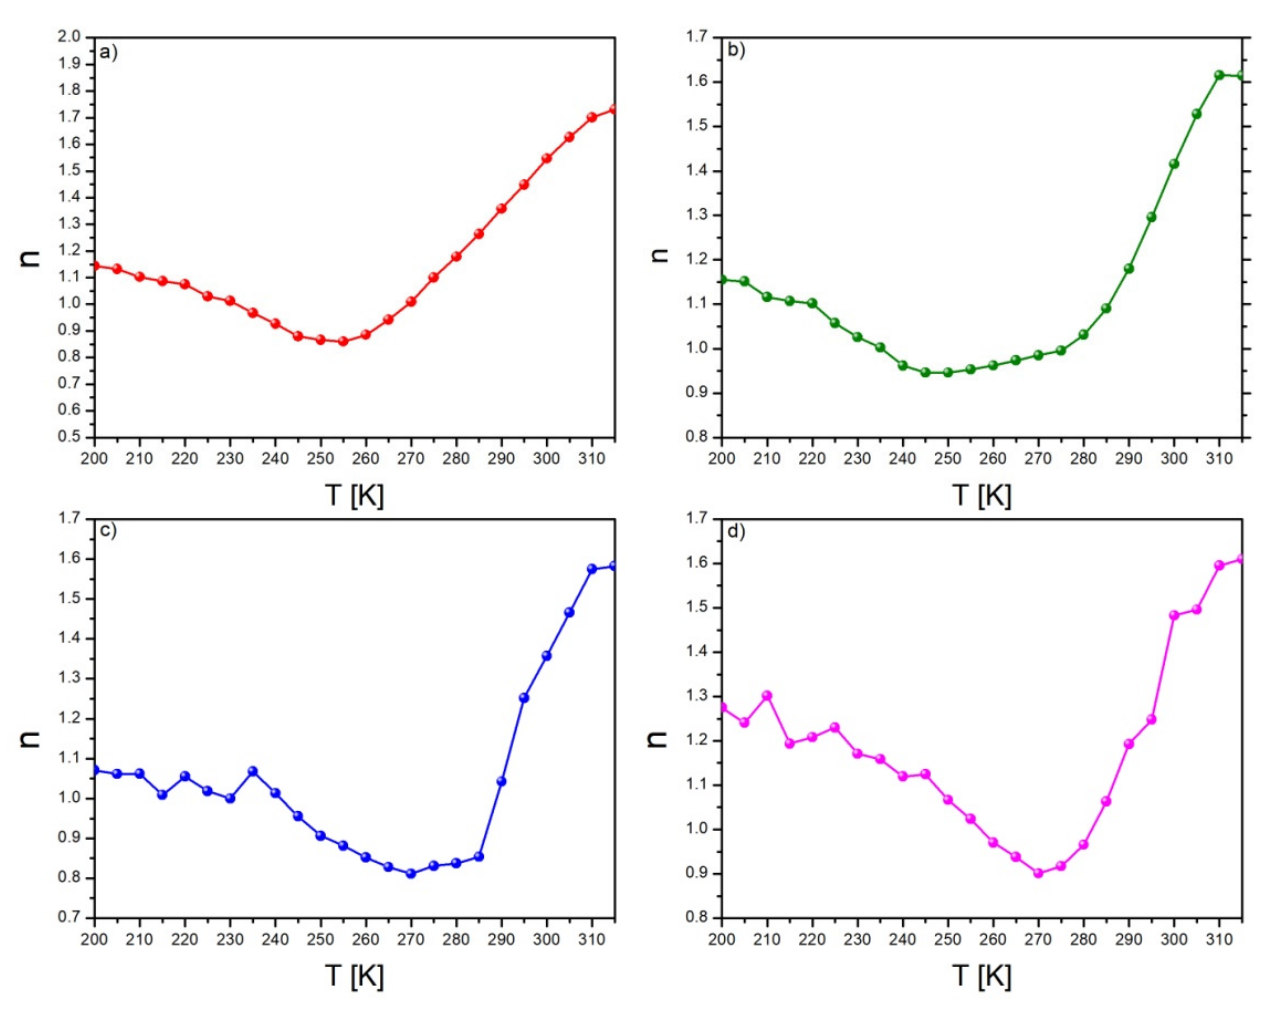
Figure 7. The temperature dependences of exponent n determined for: Gd 95 Pb 5 ( a ), Gd 90 Pb 10 ( b ), Gd 85 Pb 15 ( c ) and Gd 80 Pb 20 ( d ) alloys.